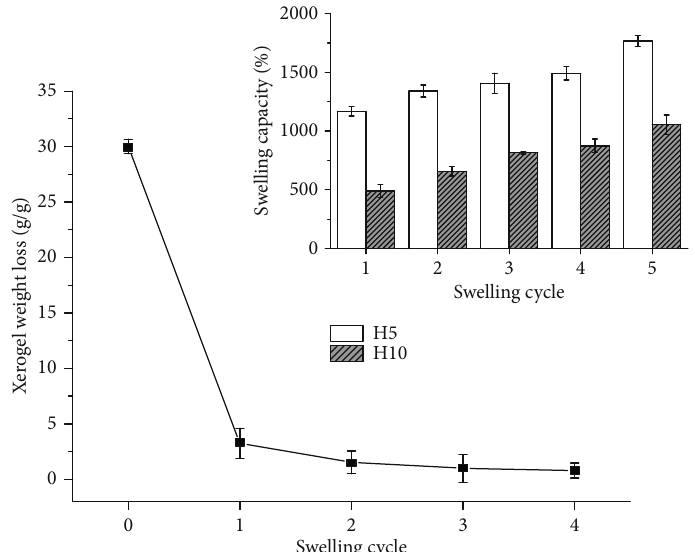
Figure 6: Water absorption capacity of the hydrogels following fi ve consecutive reswelling cycles and loss in weight (solubility of xerogel) after each drying